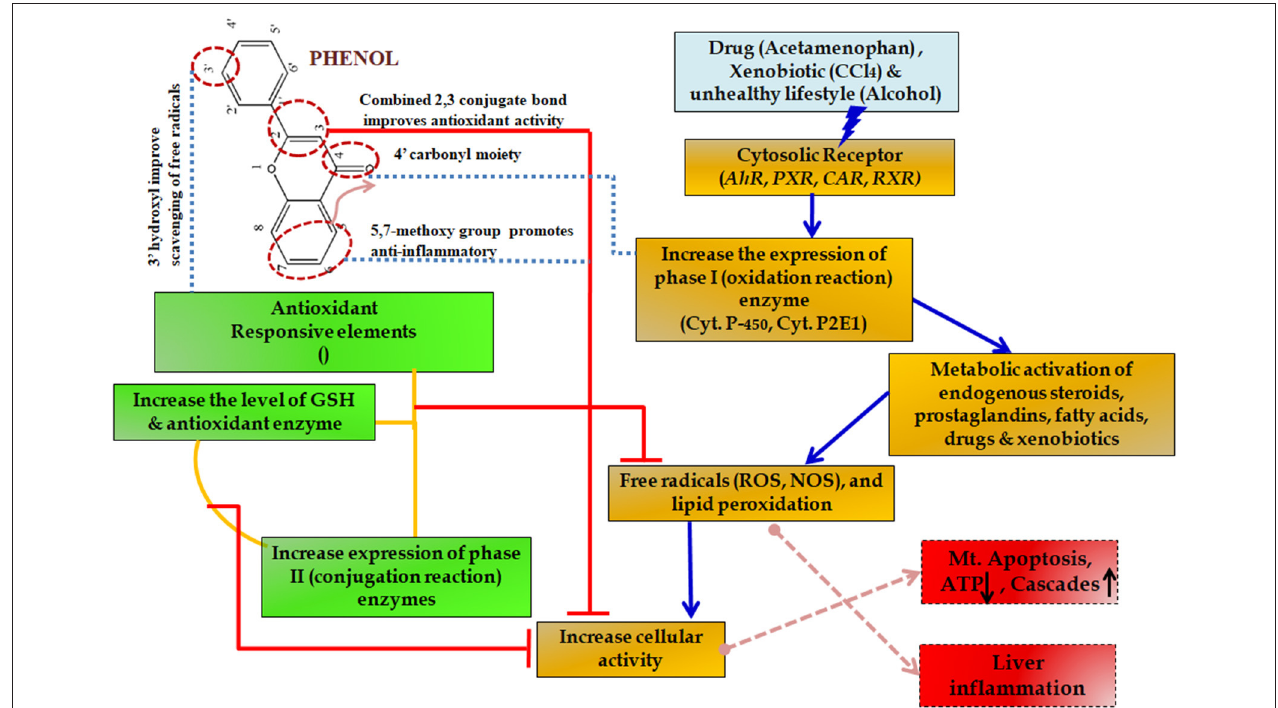
FIGURE 10 | Protective effect of phenols in various metabolic pathways in liver diseases. The upward arrow indicating upregulation and down arrow indicating downregulation of the enzymes.